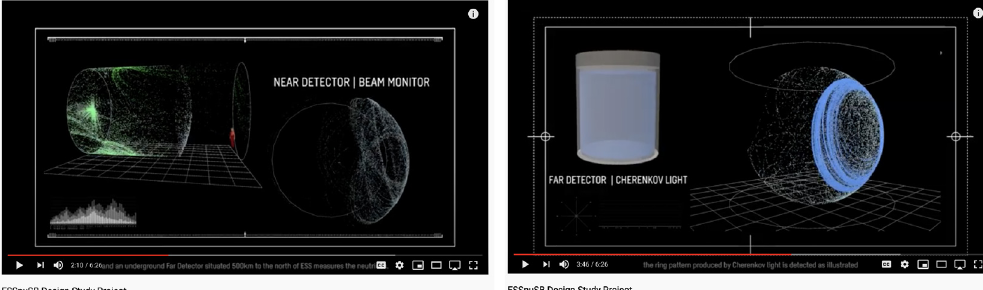
Figure 4. Cherenkov light deployment in the neard